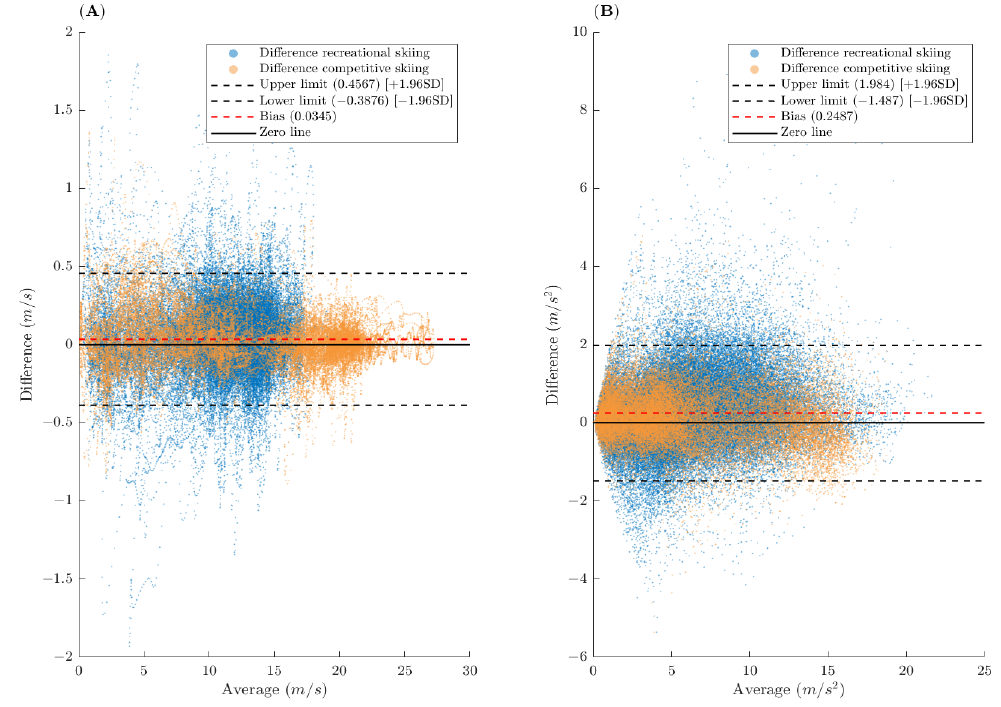
Figure 3. ( A ) Bland – Altman plot for speed error (Δ| v |). ( B ) Bland – Altman plot for acceleration error. Nomenclature: standard deviation (SD).